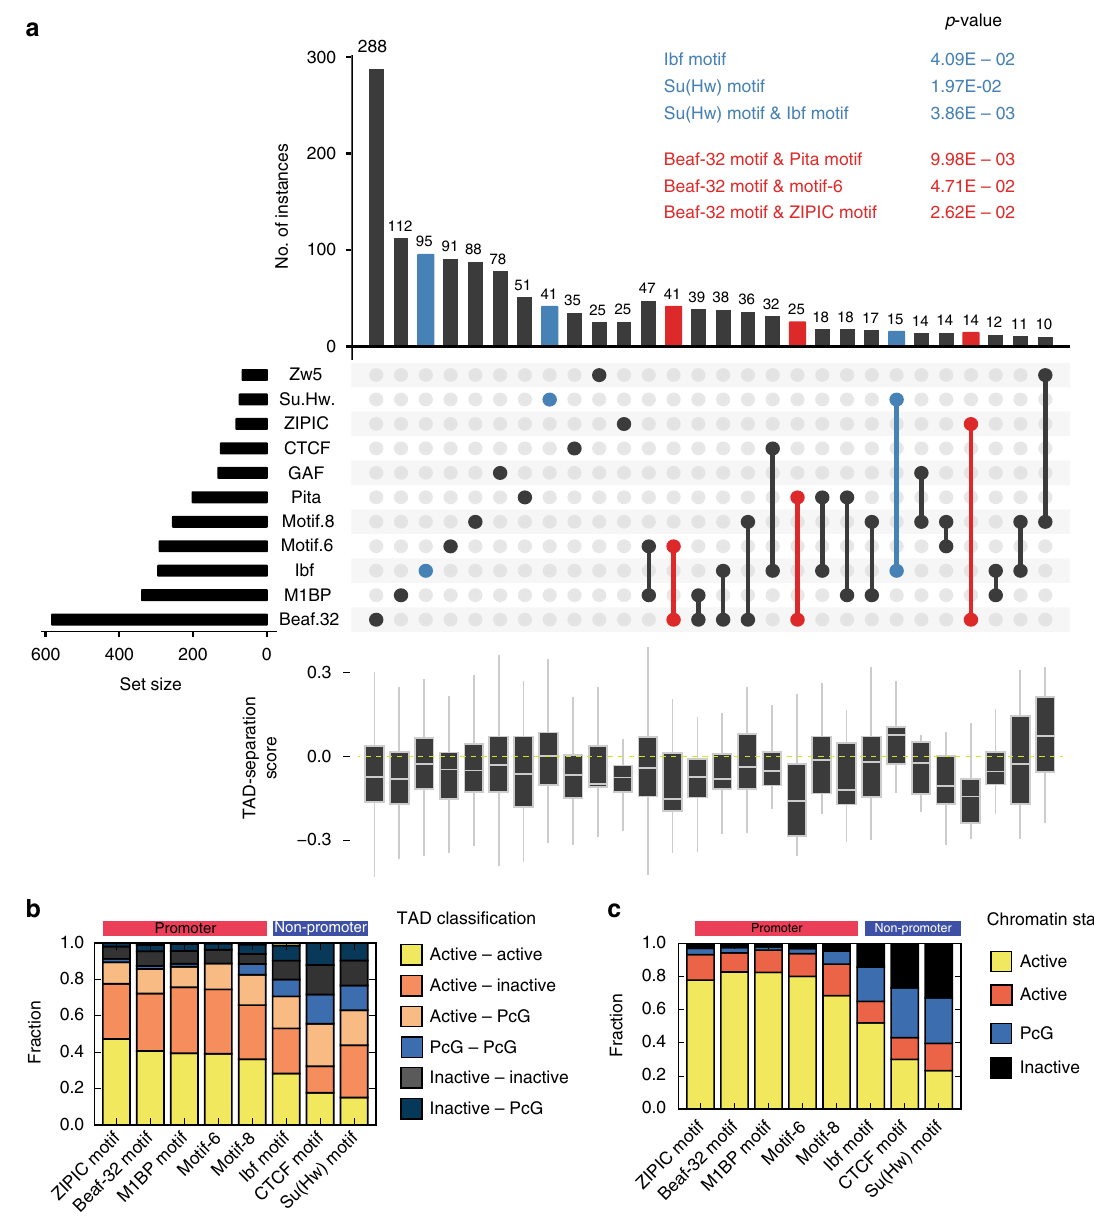
Fig. 4 Promoter and non-promoter boundary motifs show marked differences. a TAD-separation score at boundaries grouped by the motif presence. For this analysis we considered a motif to be present if the motif overlaps with a ChIP-seq peak (Methods section). The bars show the overlap between the indicated motifs below. The boxplots show the distribution of the respective TAD-separation score. The sets highlighted in blue have a TAD-separation score distribution signi fi cantly larger than the overall TAD-separation score. The p -values (Wilcoxon rank-sum test) are shown above the fi gure. Similarly, the sets highlighted in red have a distribution signi fi cantly smaller. Only motif combinations having > 10 instances are shown. Motif combinations with three or more motifs were rare. The intersections were plotted using UpSetR 70 . An overview of the motif overlaps can be seen in Supplementary Figure 4a. b Frequency of fl anking TAD types (as classi fi ed in Fig. 1d) per boundary motif. c Frequency of the chromatin state from ref.